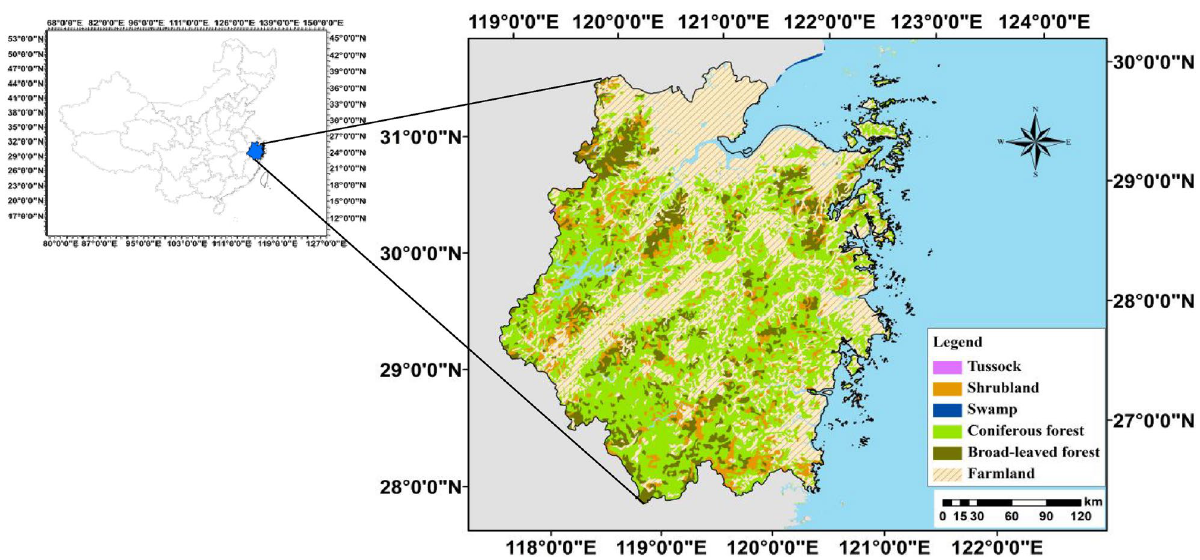
Figure 1. Spatial patterns of digital elevation model over the Zhejiang province,